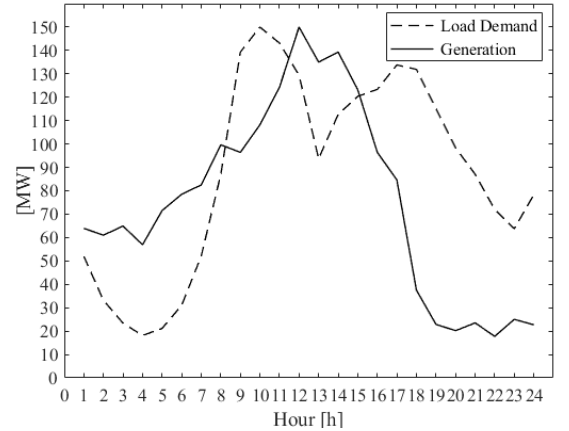
Figure 12. Daily profiles of total load and generation in Area 2.